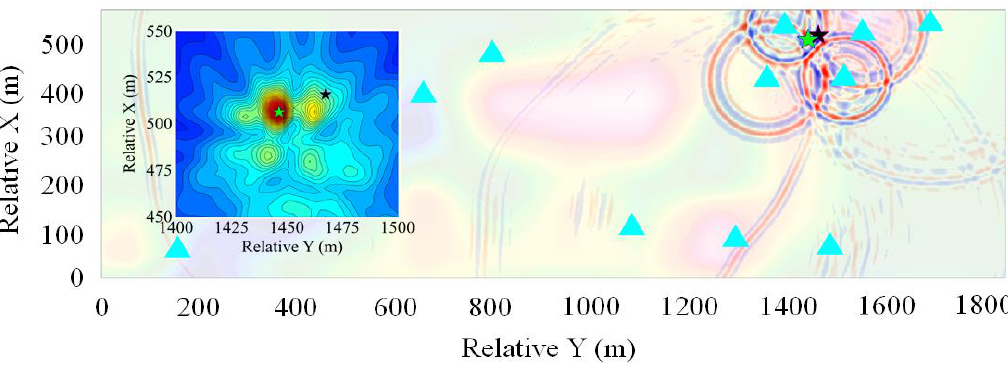
Figure 9. Location results of the GBRTM location method based on windowed recording waveforms of the blasting event 1. The 2D velocity slice shown in the transparency base map show is defined by the 2D spatial plane with the smallest projection distance to all sensors recording this event and containing the true source of blasting event 1. The time of wavefield plot correspond the moment when the wavefields from all the sensors are approximately focused at a point. The black star represents the actual location of the blasting event, while the green star represents the location determined by the GBRTM method. The left panel shows the enlarged map of the stacking amplitude imaging near the true source location using autocorrelation imaging condition.